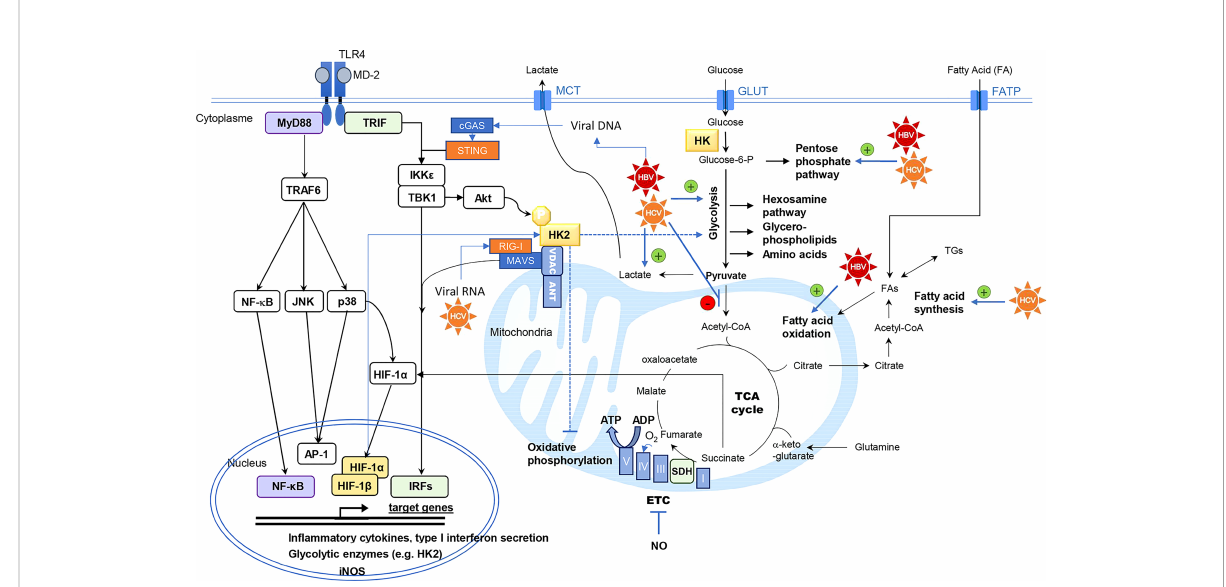
FIGURE 1 Interconnexion between innate immunity signaling pathways and central carbon metabolism of the cell. Hexokinase (HK) activity is the rate- limiting enzyme controlling glucose entry into glycolysis. Intermediary metabolites of glycolysis are precursors of anabolic pathways (pentose phosphate pathway, hexosamine pathway, glycerol-phospholipids and amino acids biosynthesis). Pyruvate is converted to acetyl-CoA into the mitochondria, fueling the tricarboxylic acid cycle (TCA) cycle. This cycle is coupled to oxidative phosphorylation by the succinate dehydrogenase (SDH) which is the complex II of the electron transfer chain (ETC). Under aerobic conditions, electron transport through the ETC (Complex I to V) generates ATP by oxidative phosphorylation. HCV and HBV have been described as modulators of the central carbon metabolism by different mechanisms, targeting glycolysis, lactate production, mitochondrial usage of pyruvate, fatty acid oxidation or synthesis. Thereby these viruses can rewire the fl ow of metabolites in these connected metabolic pathways. Viral RNA and DNA are detected by retinoic acid-inducible gene I (RIG-I) and cGAS respectively. RIG-I signaling is mediated by mitochondrial antiviral signaling protein (MAVS) polymerization at the mitochondrial membrane, triggering TANK-binding kinase 1 (TBK1)/ inhibitor of NF- k B kinase subunit epsilon (IKK e ) activation. The stimulator of IFN genes protein (STING) is an essential signal transducer of cGAS and it also functions as an adapter in the sensing of RNA viruses via RIG-I. Infected cells also produce danger signals such as high mobility group box 1 (HMGB1) which is a ligand of Toll- like receptor (TLR) 4. TLR4 stimulation results in the activation of nuclear factor- k B (NF k B), c-Jun N-terminal kinase (JNK), p38-mitogen activated protein kinase (MAPK), inducing the secretion of pro-in fl ammatory cytokines, and of TBK1/IKK e inducing interferon response factors (IRFs)-dependent type I interferon secretion and phosphorylation of protein kinase B/Akt. Hexokinase-2 (HK2) phosphorylation at Thr473 by Akt promotes HK2 binding to mitochondrial voltage-dependent anion channel (VDAC), where it also interacts with MAVS, the signaling adaptor of RIG-I. Mitochondrial binding of HK2 is associated with enhanced glycolytic and reduced oxidative phosphorylation activities. In human monocyte-derived DCs, p38-MAPK activation results in hypoxia-induced factor (HIF)-1 a accumulation, enhancing the expression of metabolic enzymes such as HK2, inducible nitric oxide synthase (iNOS) and pro-IL-1 b . Nitric oxide (NO) radical produced by iNOS can inhibit the mitochondrial respiratory chain. When succinate accumulates in the cell, this metabolite inhibits prolyl-hydroxylase domain (PHD) enzymes that degrade HIF-1 a thus favoring its accumulation. Adenine nucleotide translocase (ANT), fatty acid (FA), fatty acid transporter (FATP), glucose transporter (GLUT), monocarboxylic acid transporter (MCT), triglyceride